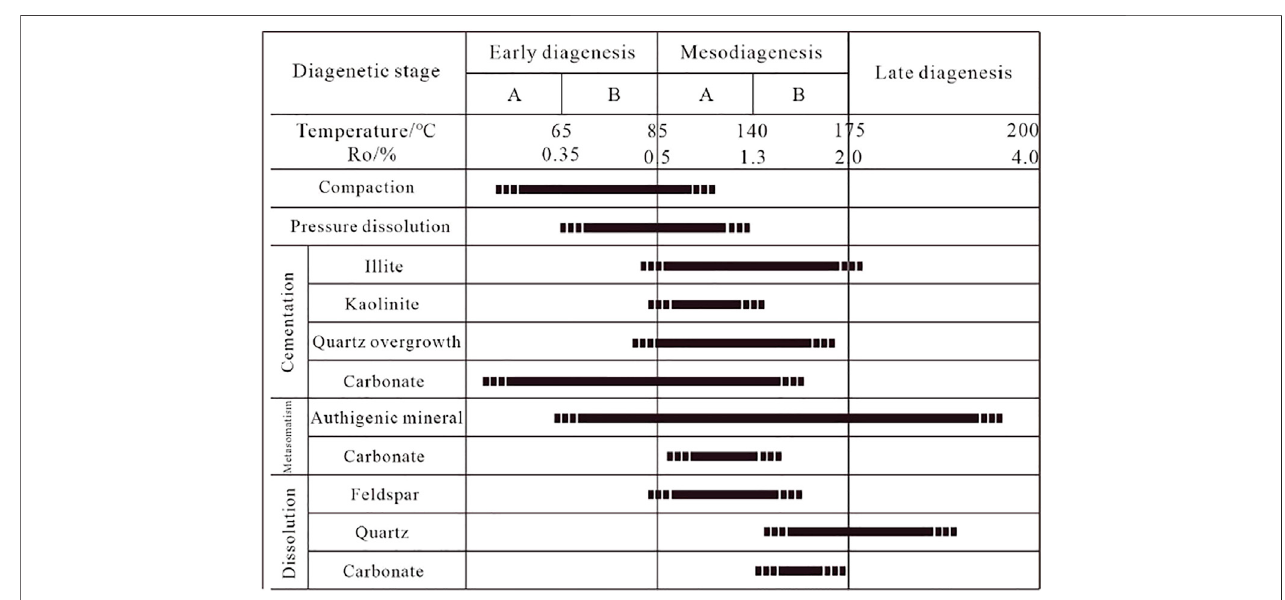
FIGURE 8 | Diagenetic sequence of the Upper Paleozoic reservoirs in the Dongpu Depression.